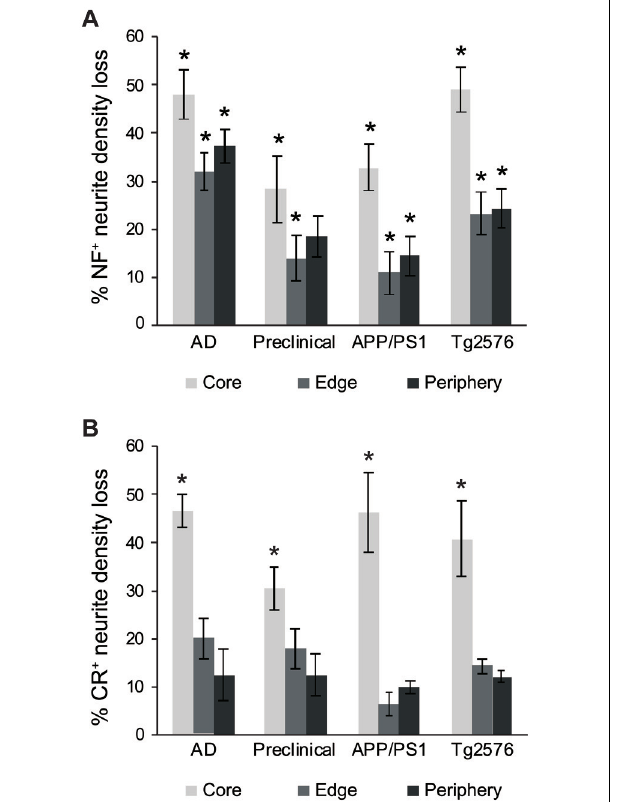
FIGURE 5 | Graphs showing the percentage neurite density loss for NF + (A) and CR + (B) neurites. There is a significant NF + neurite density loss for the different case types across all three regions ( A , * p < 0.01, ANOVA with Dunnett’s post hoc test), whereas CR + neurite density loss for the different case types was significant only in the plaque-core ( B , * p < 0.01). Error bars denote standard error of the mean.